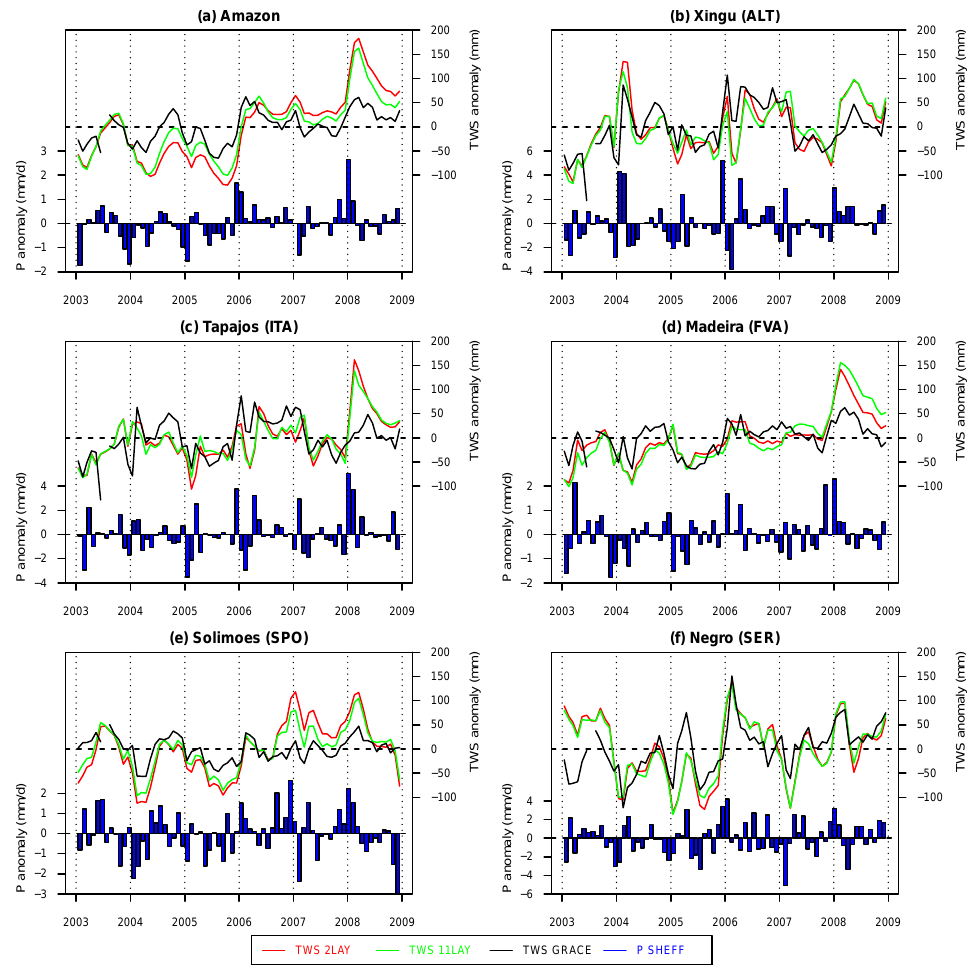
Figure 4. Interannual monthly variation of deseasonalized TWS (mm) from simulations (2LAY and 11LAY) compared to GRACE data, and Sheffield precipitation anomalies (mmd − 1 ), for the Amazon Basin and its sub-basins, for the period 2003–2008.